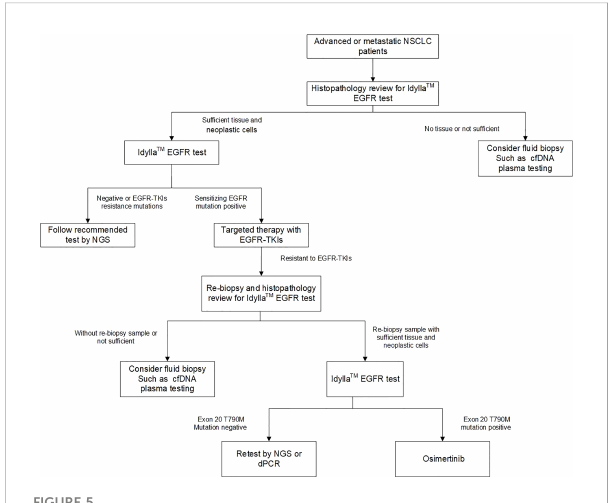
FIGURE 5 An optimized work fl ow for molecular diagnosis of NSCLC by combining rapid EGFR detection with genomic pro fi ling by NGS.